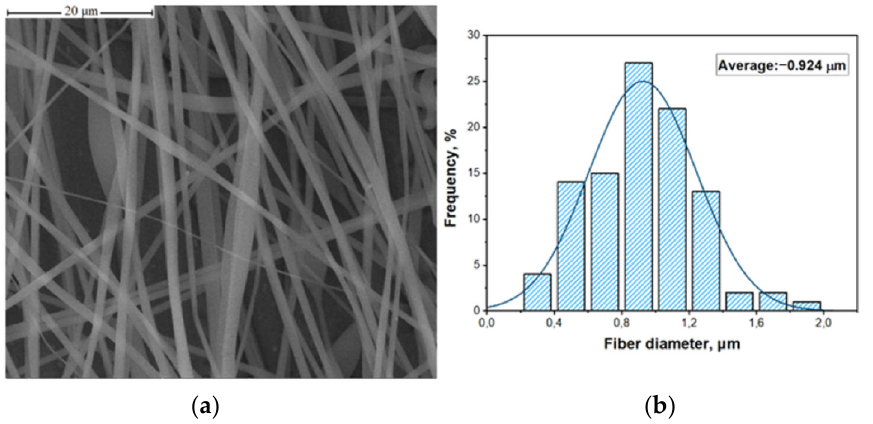
Figure 5. ( a ) SEM image of pure PAN fibers; ( b ) distribution of PAN fibers according to diameter.